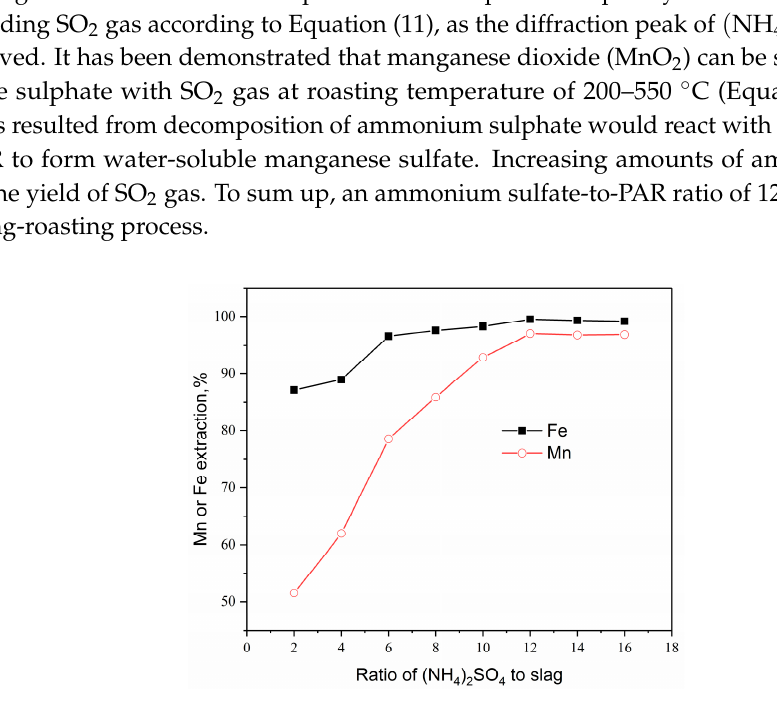
Figure 5. The effect of ammonium-to-sulphate ratio on the extraction of iron and manganese from PAR.